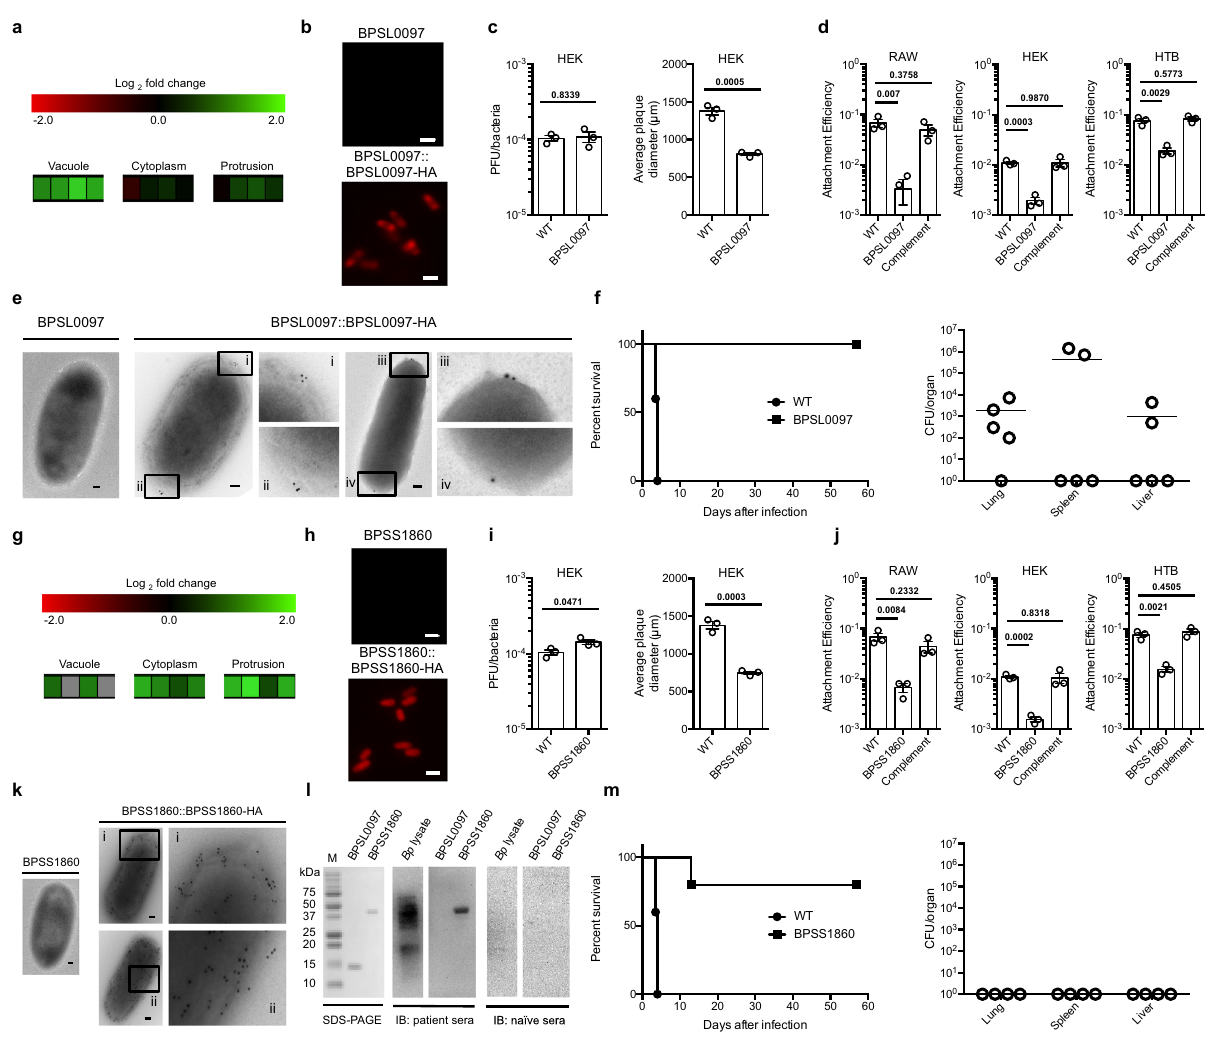
Fig. 2 Characterizations of BPSL0097 and BPSS1860 mutants. a The BPSL0097 gene is upregulated within the macrophage vacuole. First three boxes of each infection stage represent three biological replicates, the fourth represents the mean. b Immuno fl uorescence to a BPSL0097 - HA fusion strain suggests that BPSL0097 is located on the surface of Bp while the BPSL0097 mutant strain showed no signal. Scale bar = 1 μ m. c Numbers of plaques formed (PFU) by the BPSL0097 mutant in HEK293T monolayer ( n = 3) is comparable to wild-type Bp indicating no defect in host cell invasion; however, reduced plaque diameters indicate overall infection defects. d The BPSL0097 mutant showed reduced attachment ef fi ciencies compared to wild-type Bp , suggesting a role in attachment to multiple host cell lines ( n = 3). e TEM con fi rms the location of BPSL0097 to be the surface of Bp and further isolates its location to the poles of the cell. Scale bar = 100 nm. f The BPSL0097 mutant is attenuated in BALB/c mice ( n = 5) when infected via the intranasal route. Bacterial burdens of surviving mice suggest that the BPSL0097 mutant persists in vivo. g BPSS1860 gene is upregulated during cell infection relative to in vitro condition. First three boxes of each infection stage represent three biological replicates, the fourth represents the mean. h Immuno fl uorescence to a BPSS1860 - HA fusion strain suggests that BPSS1860 is located on the surface of Bp while the BPSS1860 mutant strain showed no signal. Scale bar = 1 μ m. i Numbers of plaques formed (PFU) by the BPSS1860 mutant in HEK293T monolayer ( n = 3) is comparable to wild-type Bp but show reduced plaque diameters indicating an overall infection defect. j The BPSS1860 mutant showed reduced attachment ef fi ciencies compared to wild-type Bp , suggesting a role in attachment ( n = 3). k TEM con fi rms that BPSS1860 is located on the surface of Bp and that it is distributed throughout the entire cell length. Scale bar = 100 nm. l Antibodies against puri fi ed BPSS1860 were detected via immunoblot (IB) in pooled melioidosis patients ’ serum samples ( n = 7). M, Precision Plus Protein Standard (Bio-Rad). m The BPSS1860 mutant is attenuated in BALB/c mice ( n = 5) when infected via the intranasal route. The BPSS1860 mutant was completely cleared in all surviving mice. Data in bar graphs represent means± s.e.m. and analyzed via two-sided unpaired t -test. P values presented above relevant comparisons.